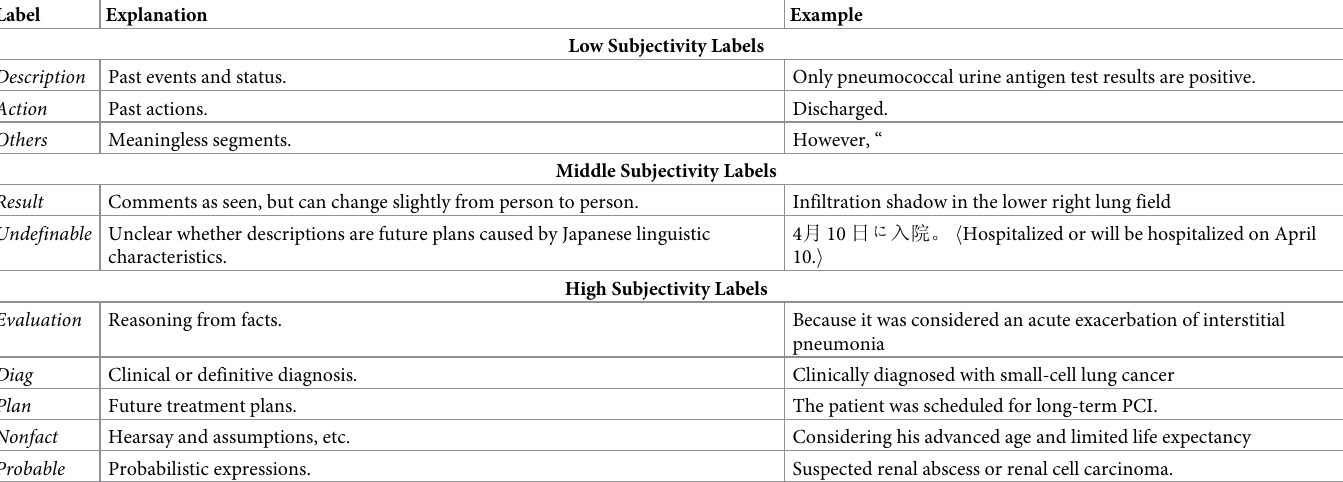
Table 1. Details of the clinical role label. It shows label names, brief explanations, and examples in discharge